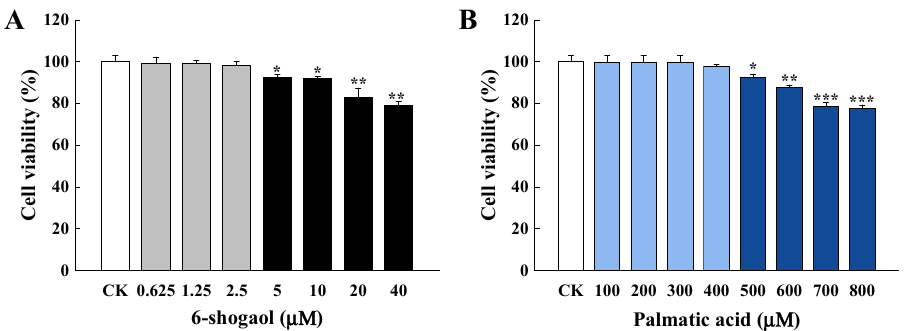
Figure 1. Effects of 6-shogaol and palmitic acid (PA) on the cell viability of Caco-2 cells: ( A ) Relative cell viability of Caco-2 cells treated with 6-shogaol (0.625, 1.25, 2.5, 5, 10, 20, or 40 µ M) for 24 h; ( B ) Relative cell viability of Caco-2 cells treated with PA (100, 200, 300, 400, 500, 600, 700, or 800 µ M) for 24 h. Data are given as the mean ± standard deviation (n = 3). * p < 0.05, ** p < 0.01, *** p < 0.001 vs. the control.